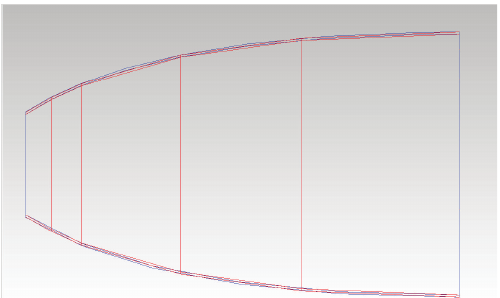
Figure 2: Ideal CPC (blue) and 5-cone (red) point-approximated